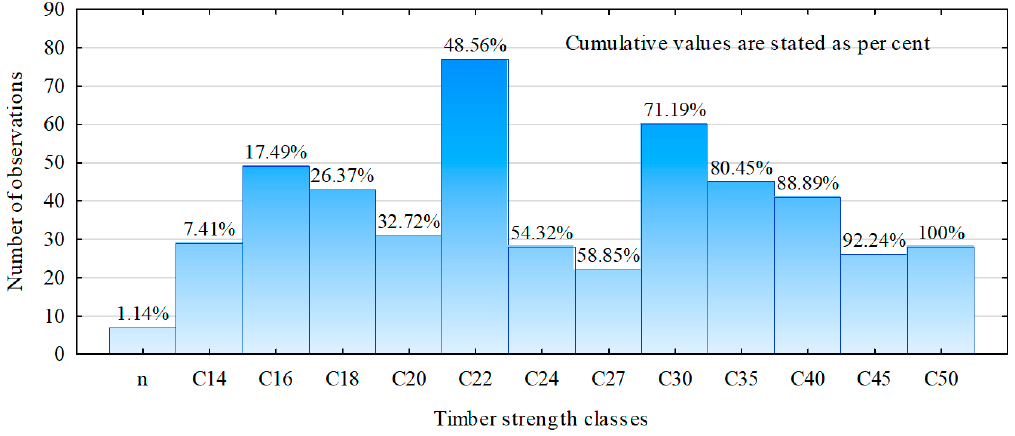
Figure 7. Number of items in strength classes for timber from the Forest Division Olesno.